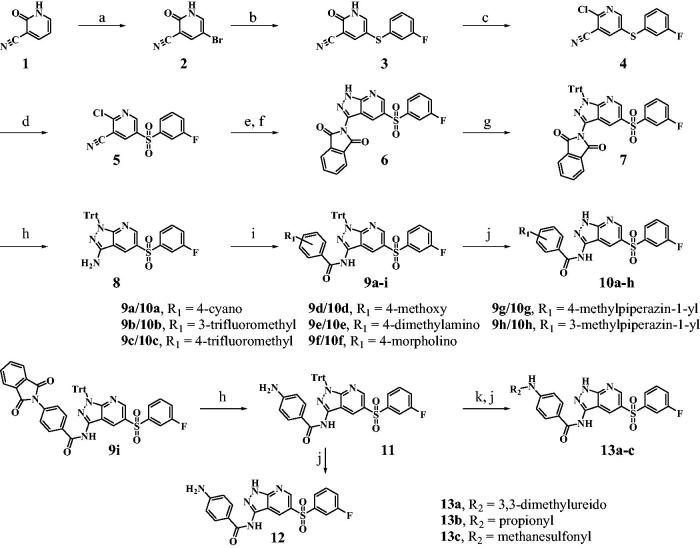
Scheme 1. Synthesis of derivatives 10a-h, 12, 13a-ca.aReagents and conditions: (a) Br2, Acetic acid, rt (85%); (b) 3-fluorobenzenethiol, copper iodide, K2CO3, DMF, 120 °C (90%); (c) PCl5, POCl3, 100 °C (93%); (d) m-CPBA, Na2SO3, DCM, 0 °C (79%); (e) hydrazine monohydrate, EtOH, 80 °C; (f) phthalic anhydride, 1,4-dioxane, 100 °C (72% over 2 steps); (g) triphenylmethyl chloride, TEA, DCM, 0 °C (75%); (h) hydrazine monohydrate, THF, EtOH, rt (85%); (i) various benzoyl chloride, DMAP, pyridine, 0 °C (70–85%); (j) TFA, DCM, rt (35–45% over 2 steps); (k) for 13a, dimethylcarbamic chloride, DMAP, pyridine, 0 °C (43%); for 13b, propionyl chloride, DMAP, pyridine, 0 °C (50%); for 13c, methanesulfonyl chloride, DMAP, pyridine, 0 °C (32%).